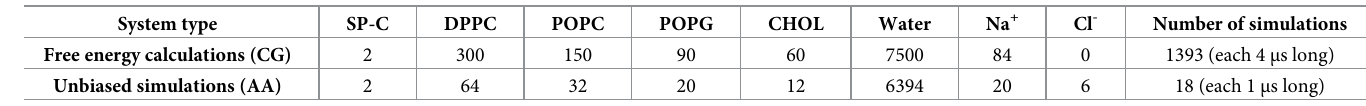
was updated every 10 steps. Electrostatic interactions were treated using the reaction-field Table 1. Detailed composition of the systems studied in this